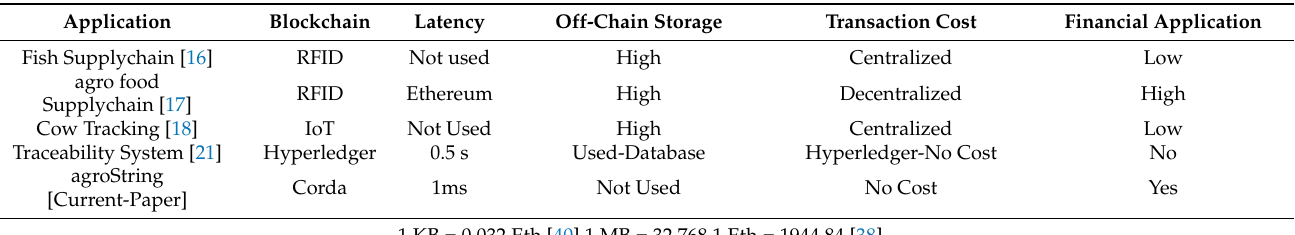
Table 3. Comparison of prior works with current